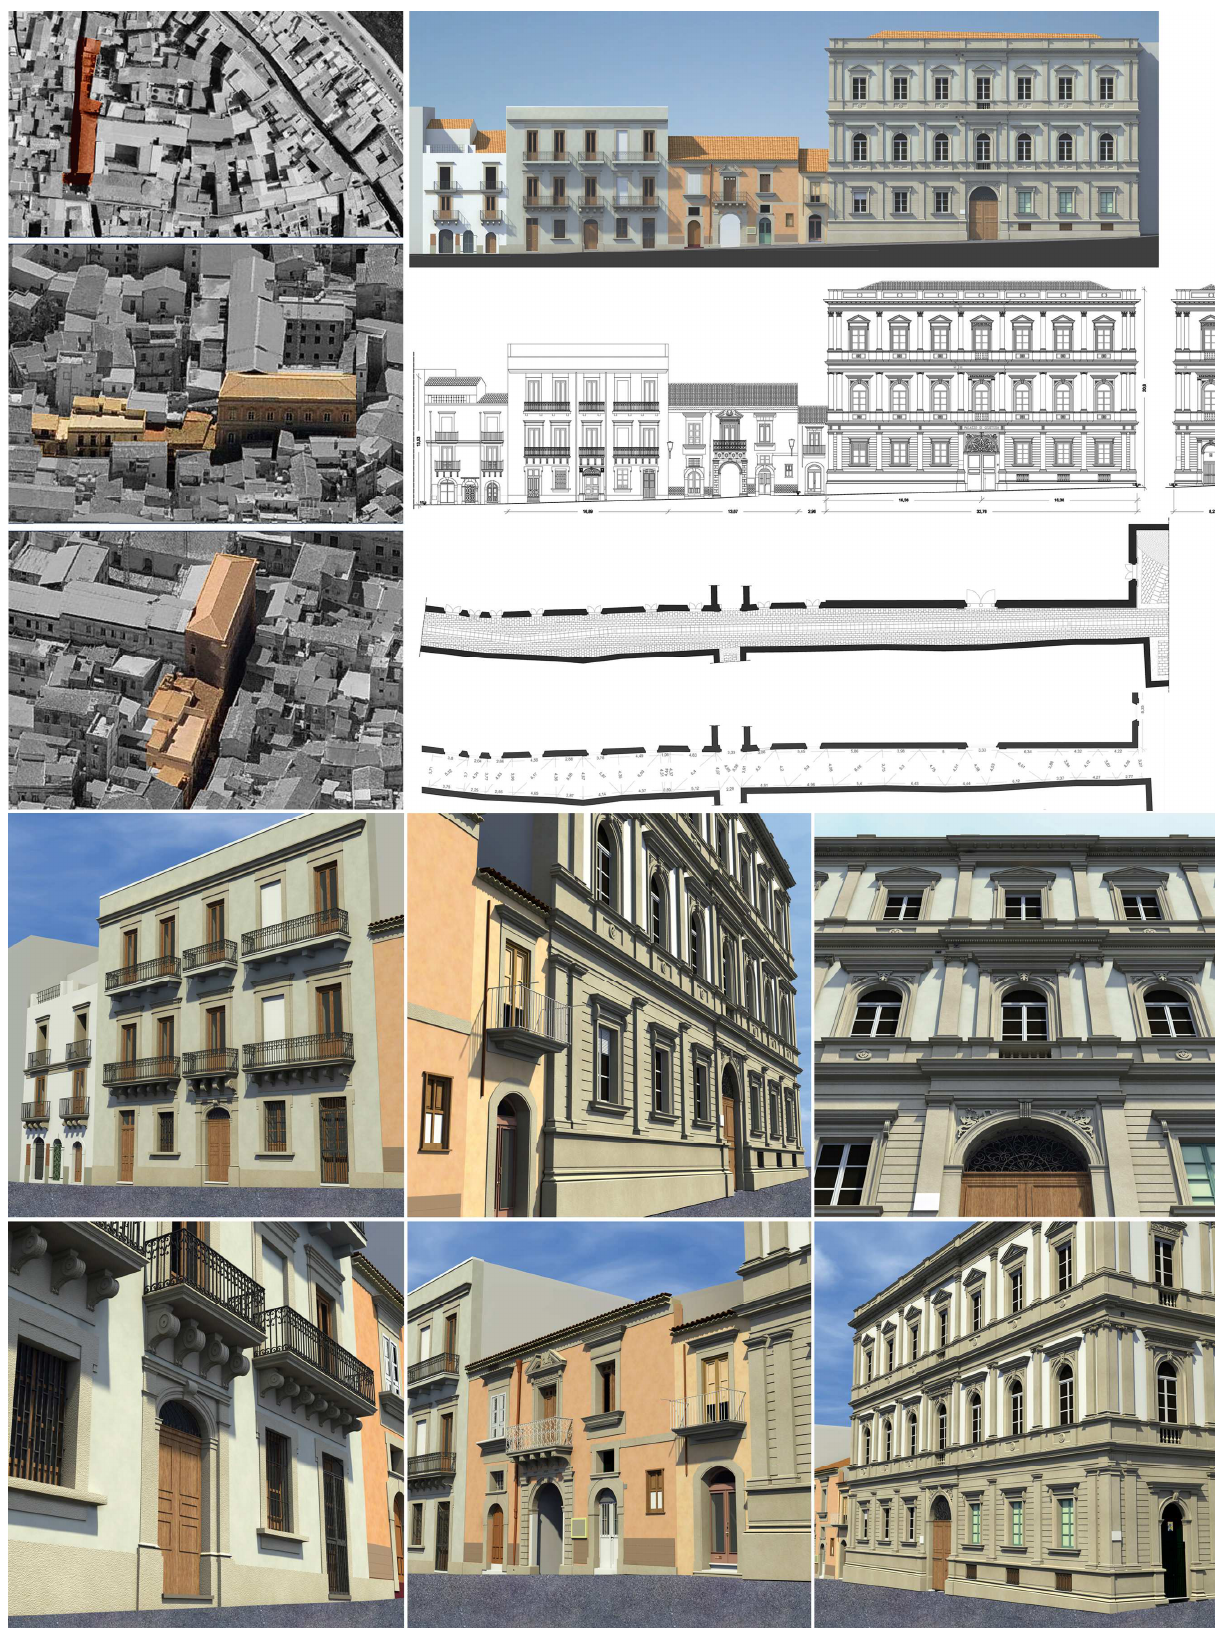
Figure 5. A logical and experimental system to define an integrated path of knowledge of the